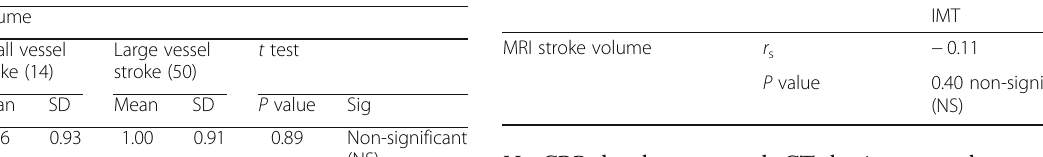
Table 8 Comparison between patients with large and small volumes regarding hs-CRP value